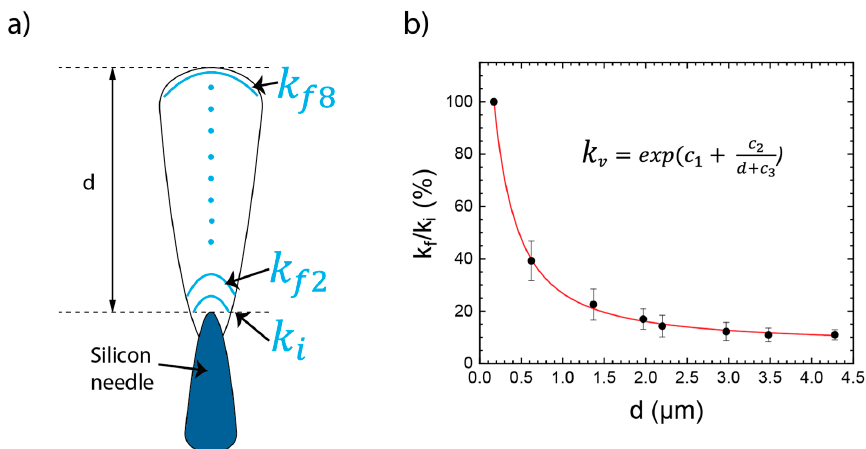
Figure 5. ( a ) Schematic illustration of the morphology of the 3D-RMS on top of the black Si needles displaying the different parameters taken for evaluation of the normalized curvature. ( b ) Normalized curvature as a function of distance to the first layer after evaluation of 4 different domains.